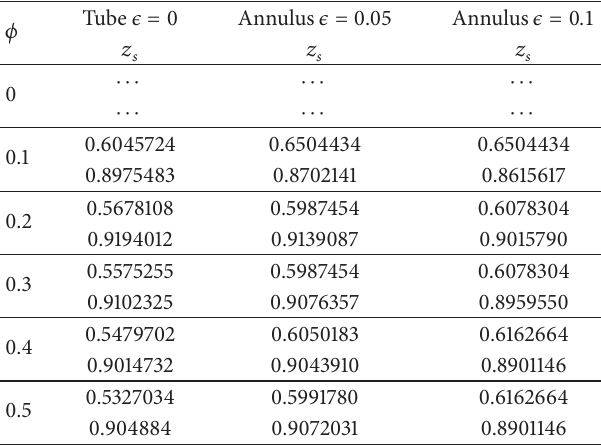
Table 1: Computed values of the flow separation points 𝑧 𝑠 for different values of amplitude ratio 𝜙 at 𝑄 = 1 , Re = 10 , Wi = 0.01 , and 𝛿 = 0.01 .